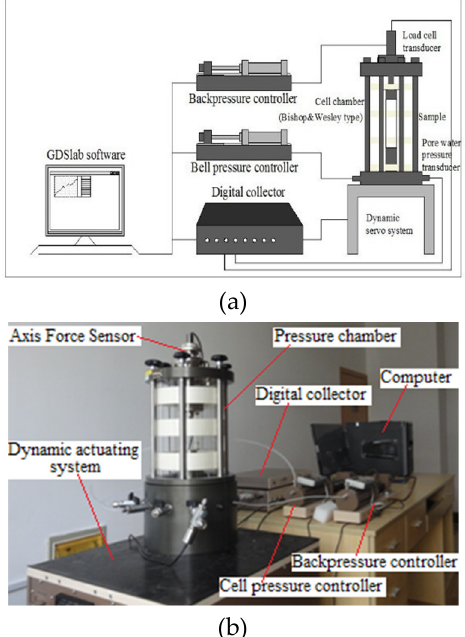
Figure 3. Cyclic triaxial apparatus used in this study: ( a ) schematic diagram of cyclic triaxial apparatus system; ( b ) cyclic triaxial apparatus.